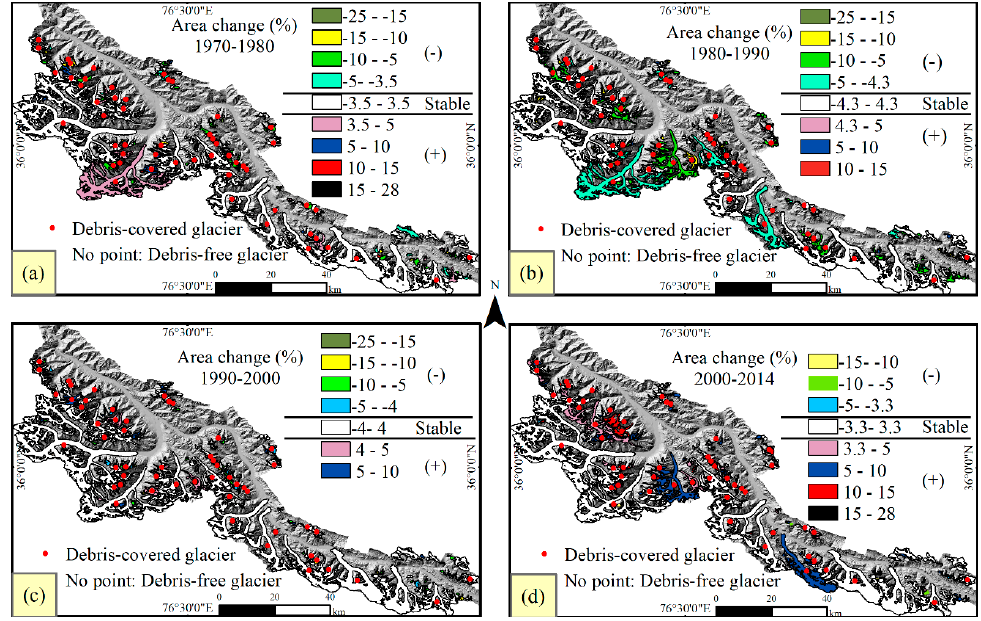
Table 5. Comparison of glacier inventories from this study (glacier area: km 2 ).